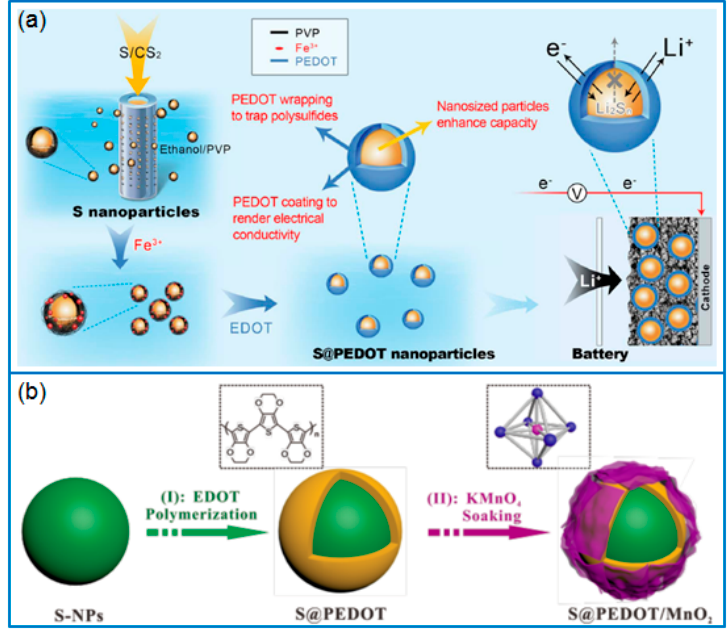
Figure 7. Schematic illustration for preparing ( a ) S/PEDOT nanoparticles and their functions [89]; ( b ) double-layer S@PEDOT/MnO 2 composite [91]. ( b ) double-layer S@PEDOT / MnO 2 composite